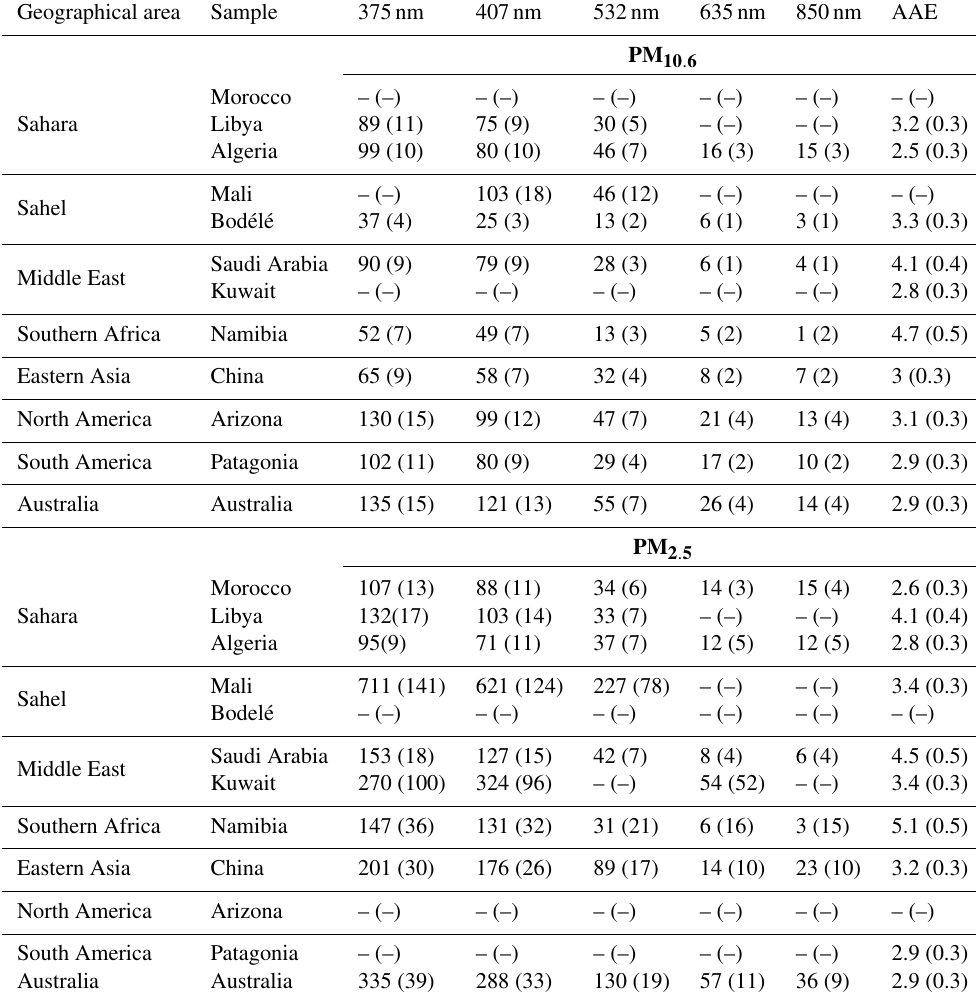
Table 4. Mass absorption efficiency (MAE, 10 − 3 m 2 g − 1 ) and Ångström absorption exponent (AAE) in the PM 10 . 6 and PM 2 . 5 size fractions. Absolute errors are in